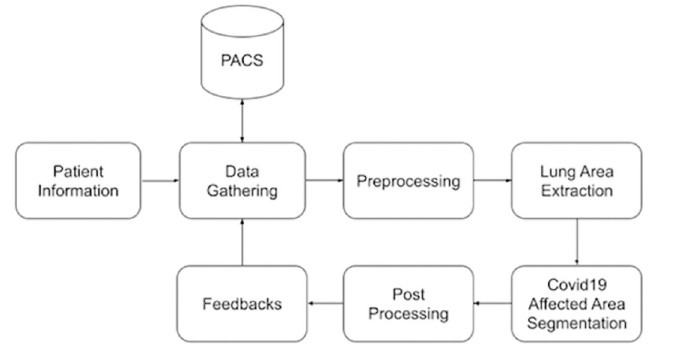
Fig 1. Block diagram of the proposed